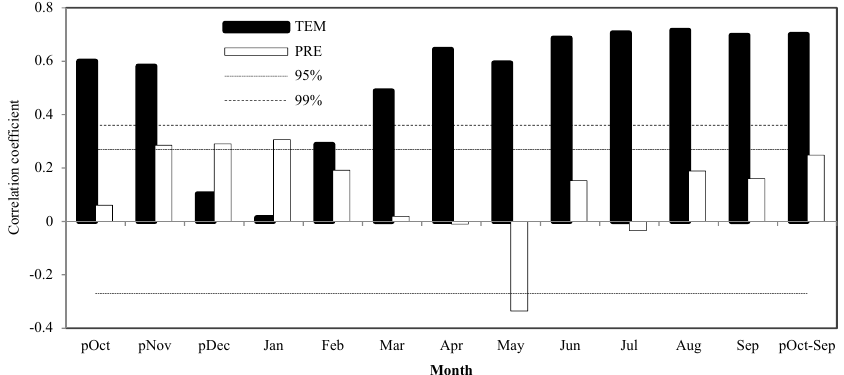
Figure 5. Correlation coefficients between regional mean chronology and the observed regional mean temperature (TEM) and precipitation (PRE) at each month for the common period 1957–2005.